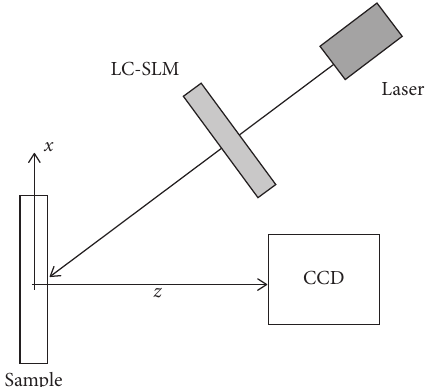
Figure 1: Geometry of the Talbot fringe projection.